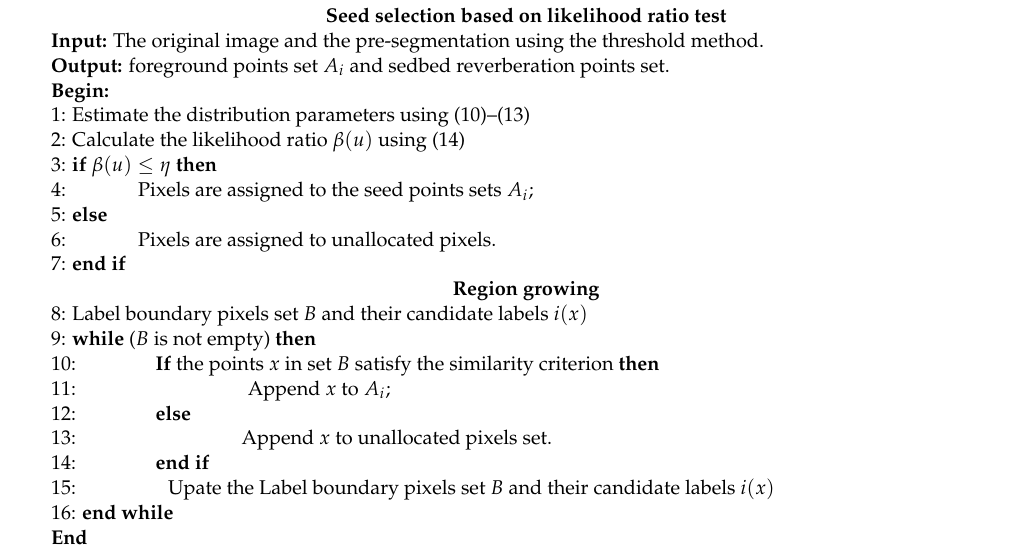
Algorithm A1 The pseudo-code for the proposed segmentation